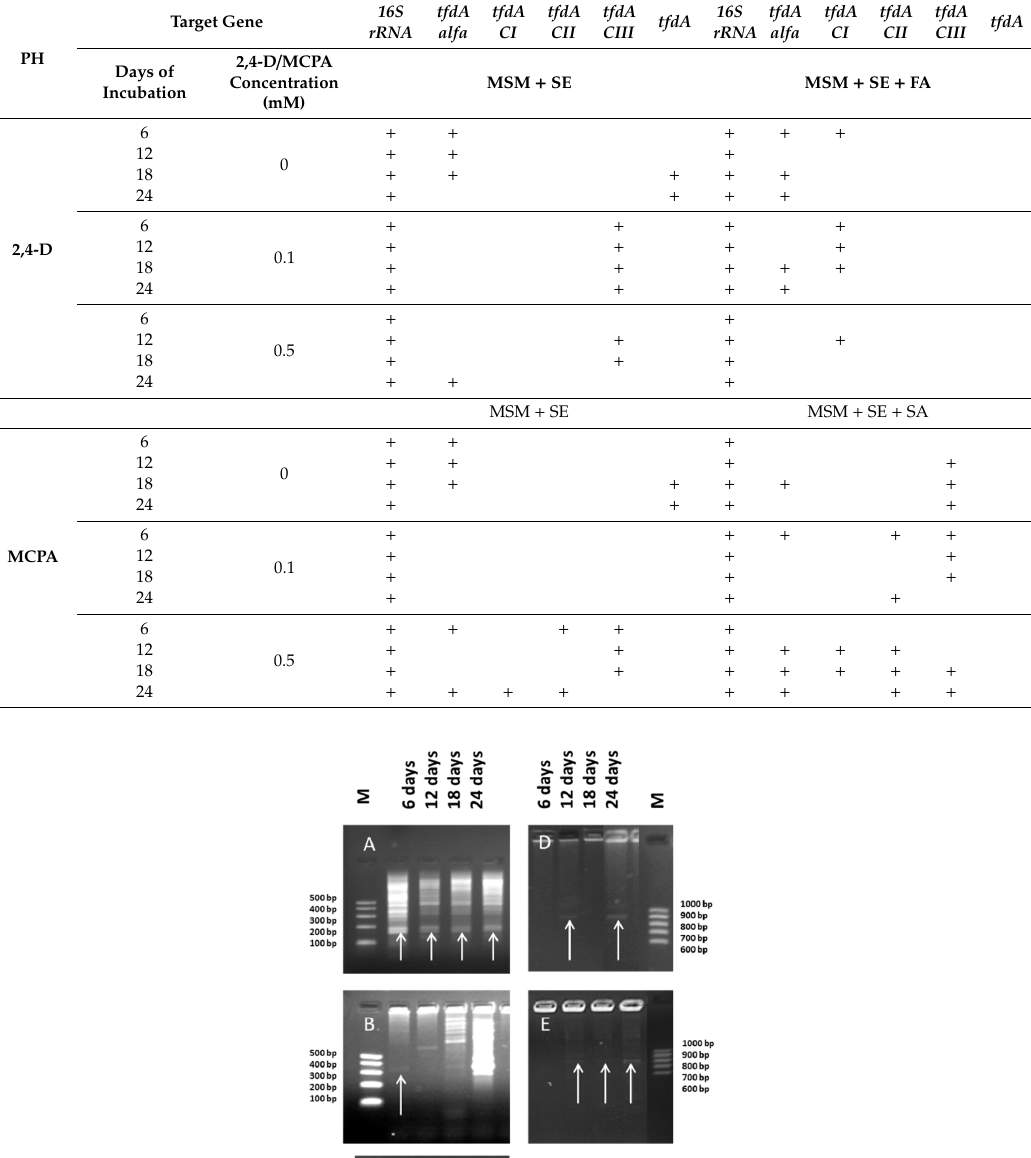
Table 3. PCR Results for Target Genes; ” + ”Presence of PCR Product on 1.5% Agar Gel Electrophoresis; CI —Class I, CII —Class II, CIII —Class III.